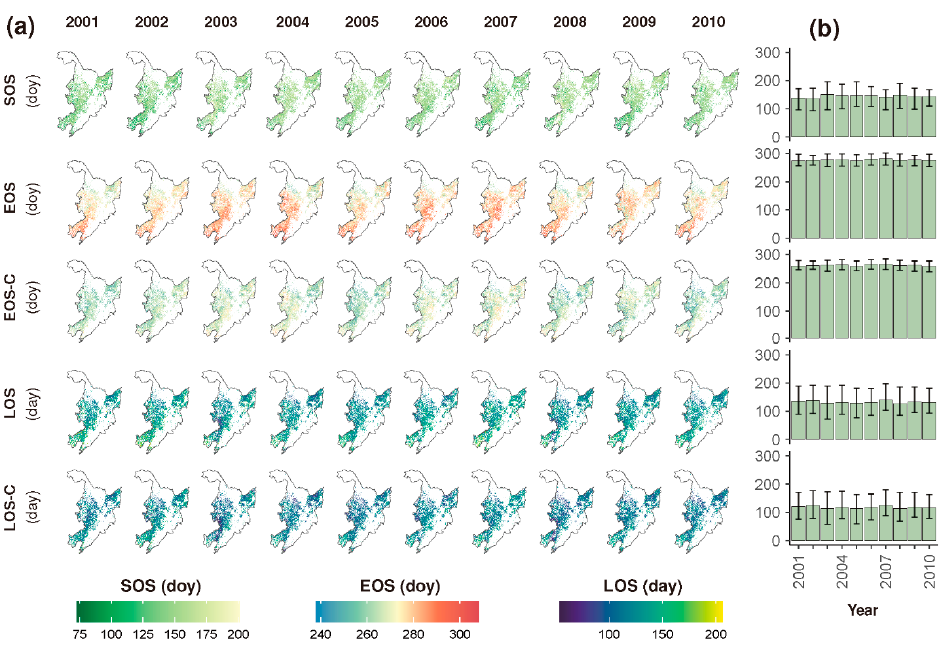
Figure 9. ( a ) The start (SOS), end (EOS), and length (LOS) of the cropland growing season in Northeast China (NEC) based on the MCD12Q2 land surface phenology product. EOS-C and LOS-C are calibrated EOS and LOS, respectively, using the climotransfer function developed in this paper; ( b ) The annual mean and 95% confidence interval of SOS, EOS, EOS-C, LOS, and LOS-C in the NEC from 2001 to 2010. Data are given in Table